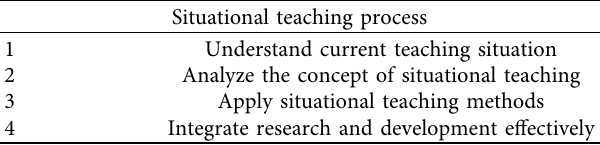
Table 2: Research flow of situational